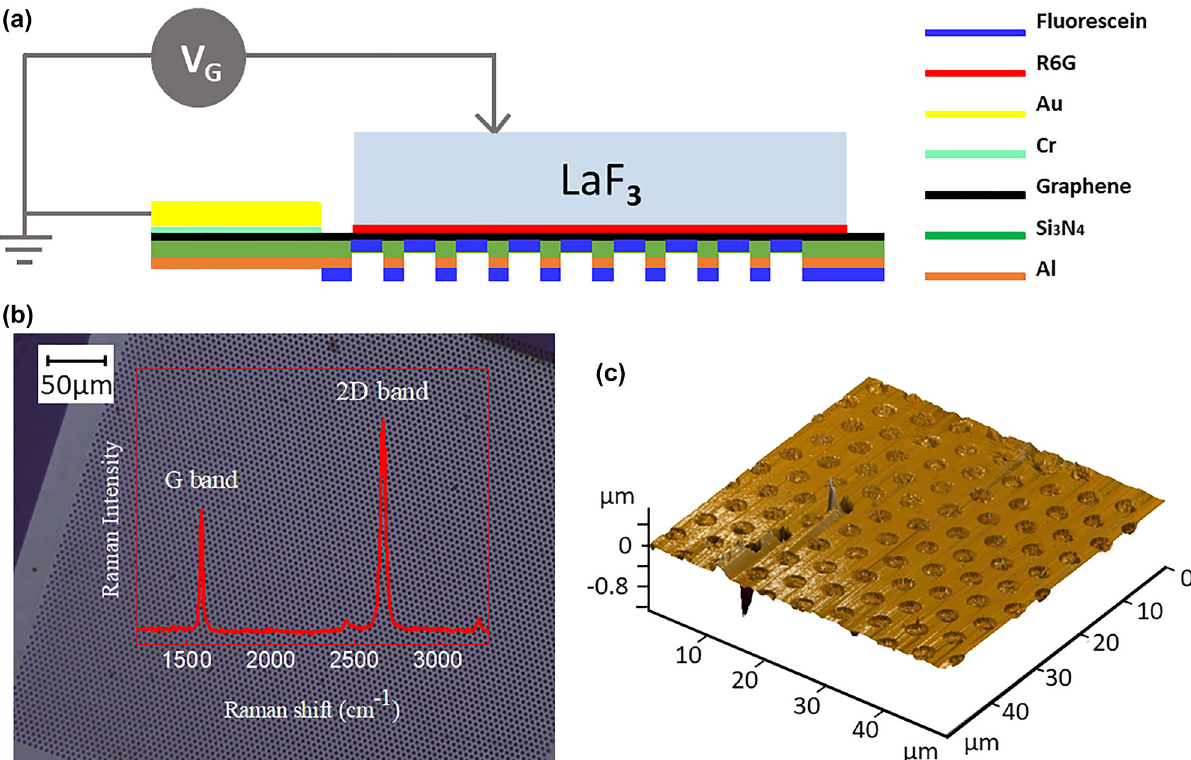
N membrane. The insert 3 4 N 3 4